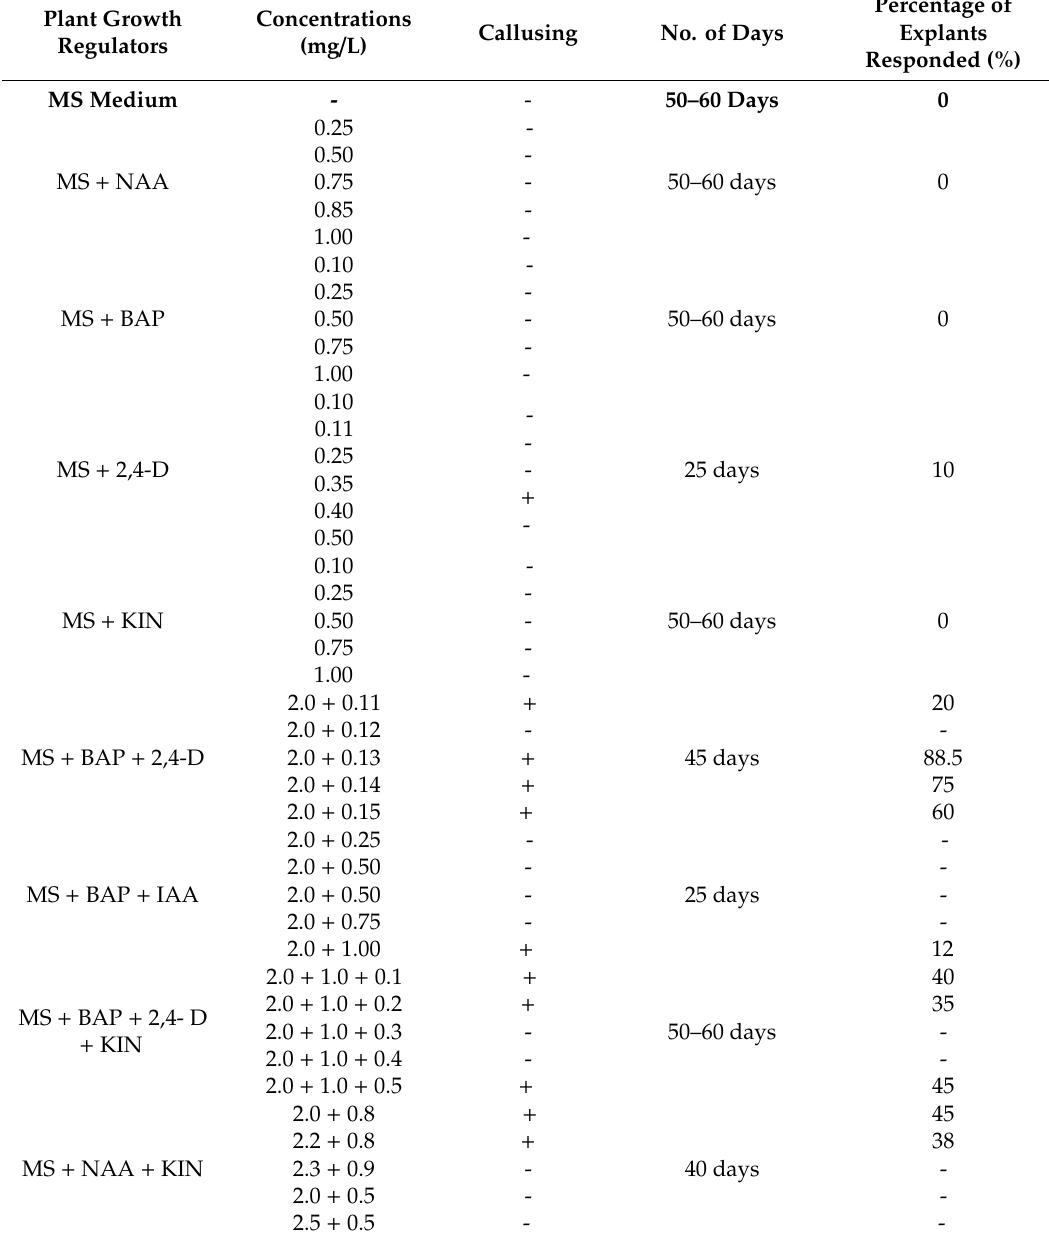
Table 1. E ff ect of plant growth regulators (PGRs) on leaf explants of Viola serpens for callus formation. Plant